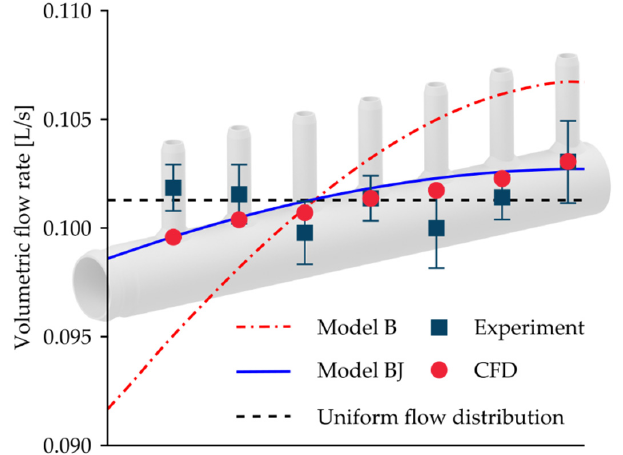
Figure 13. Volumetric flow rate distribution in the tubes of the n07 distributor. The experimental data points (average values) are plotted together with the respective observed value intervals.